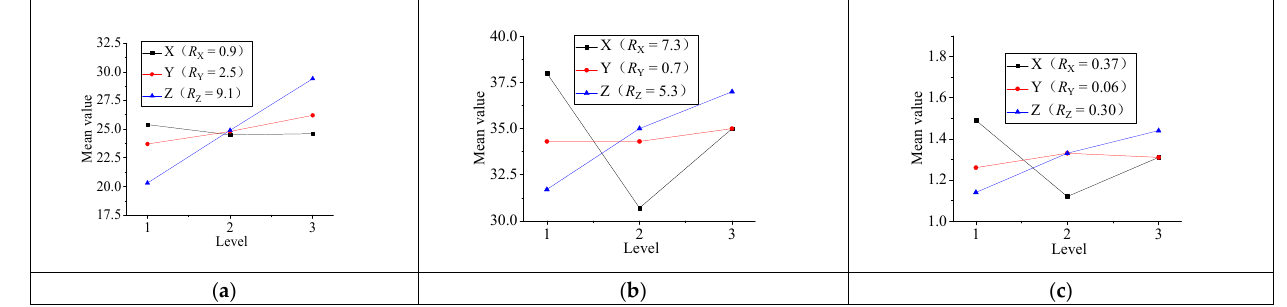
Figure 12. Parameter range analysis of film etching rate, roughness, and film resistivity. ( a ) Parameter range analysis of film etching rate. ( b ) Parameter range analysis of film roughness. ( c ) Parameter range analysis of film resistivity.